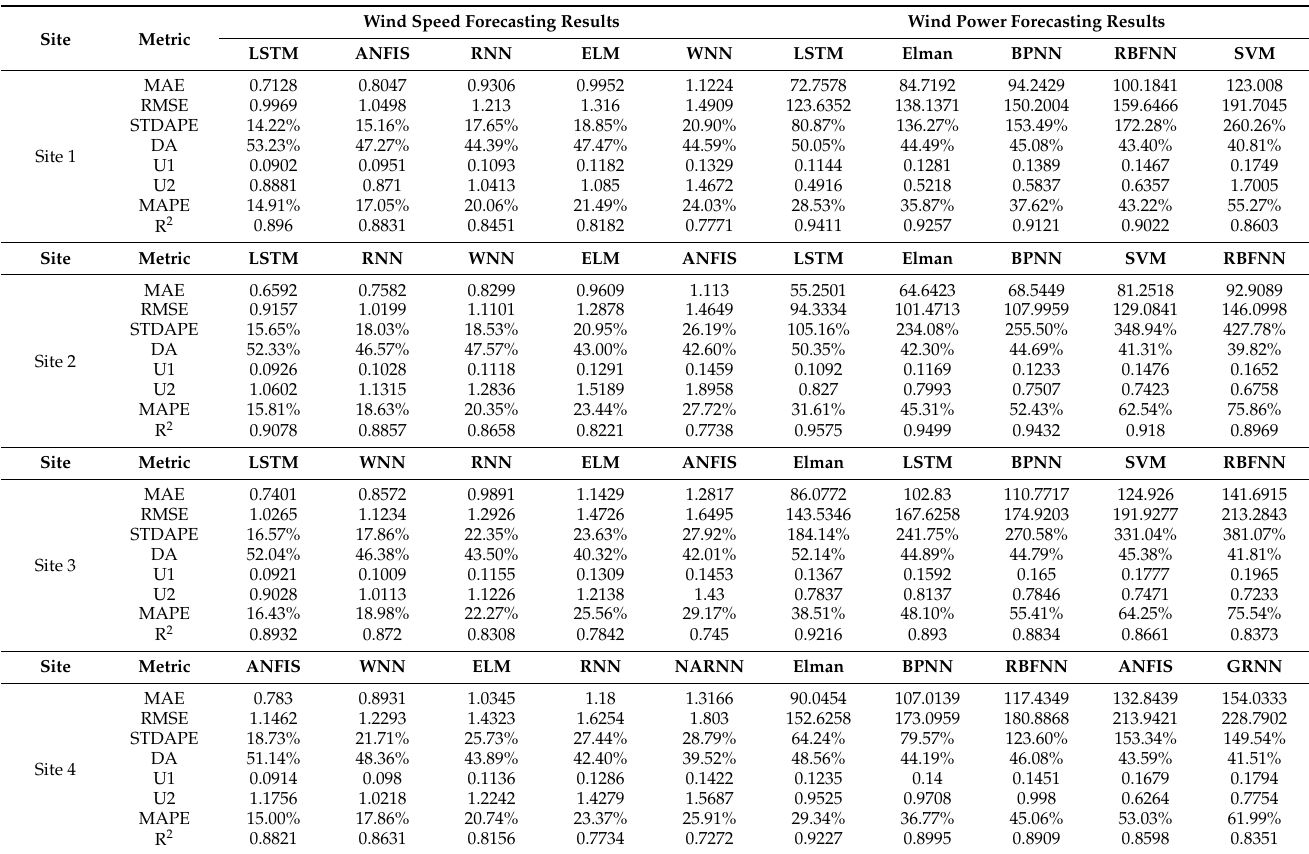
Table A4. The forecasting performance of five optimal sub-models for wind speed and wind power in the fourth